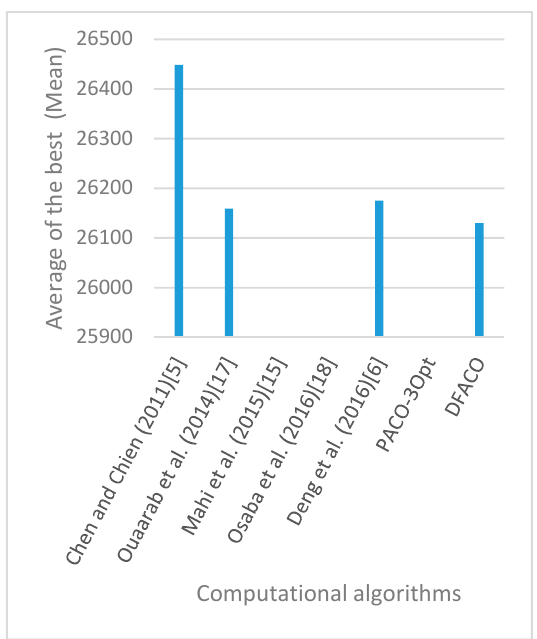
Figure 22. Average of best solutions obtained for instance kroB150 by all algorithms.